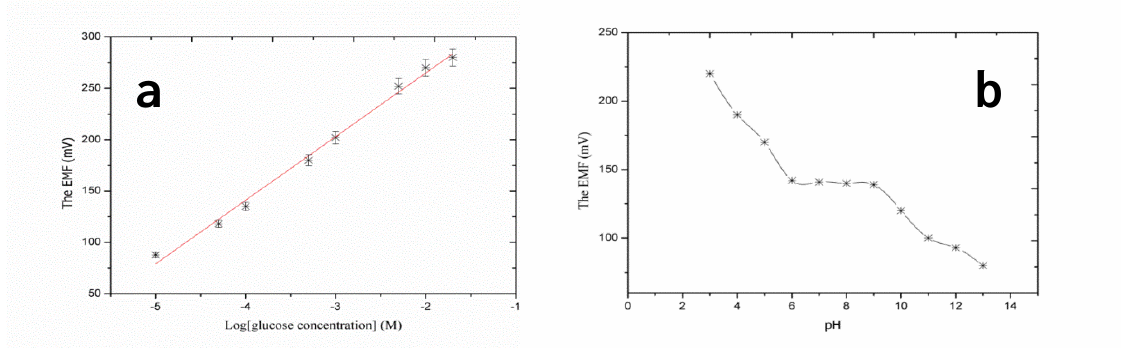
Figure 9. ( a ) Calibration curve of the glucose sensor and ( b ) the effect of pH on the glucose sensor from pH 3 to pH 12